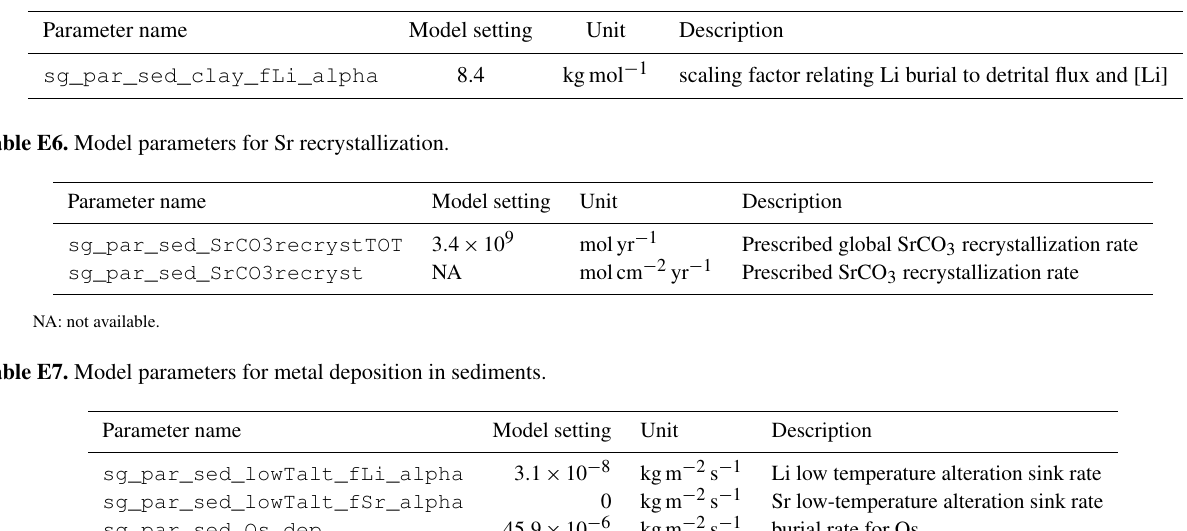
Table E5. Model parameters for weathering-related trace metal fluxes.